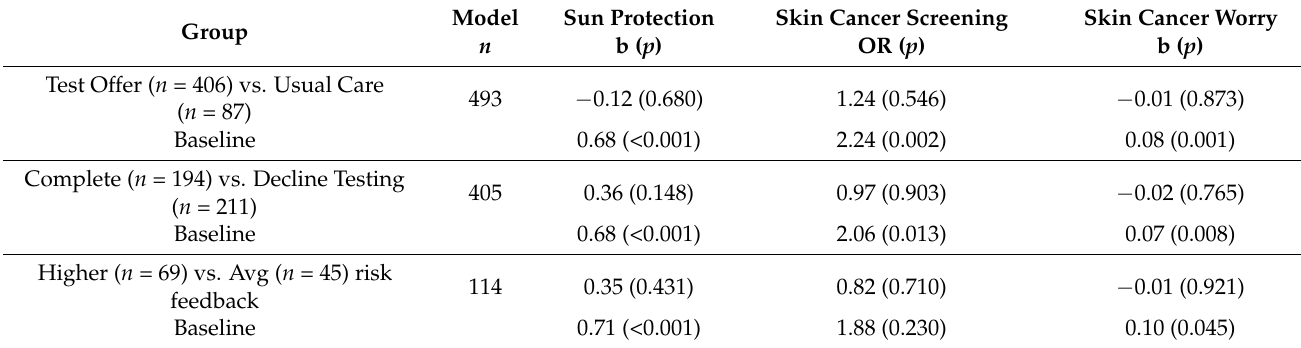
Table 3. Model estimates ( p -value) for test offer, completion, and receipt of risk feedback result, separately, on each study primary outcome (sun protection, skin cancer screening, and skin cancer worry) at 3 month follow-up.